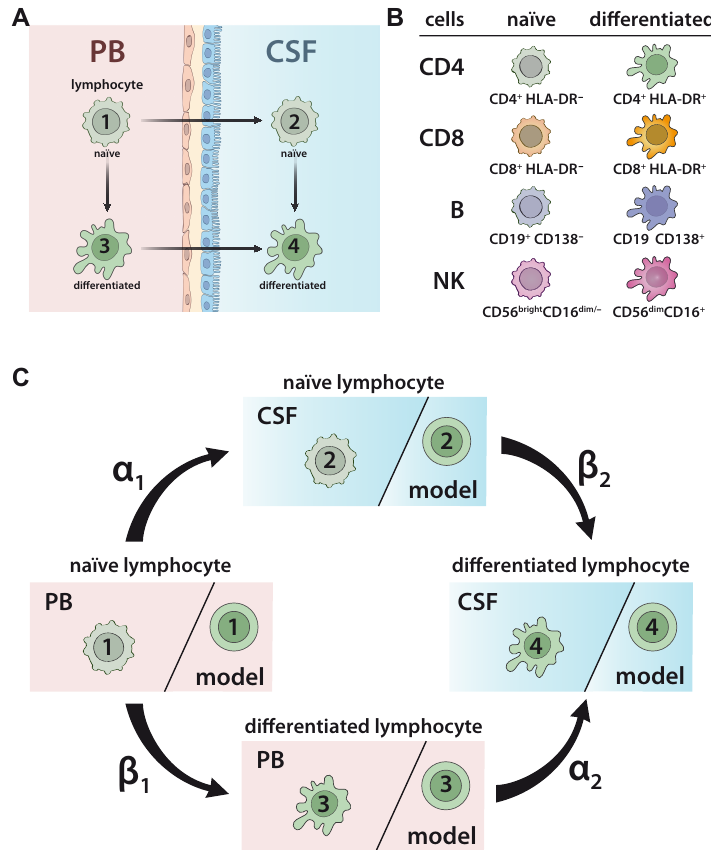
Figure 1. Model describing the relationship between naïve and di ff erentiated lymphocyte subsets in the peripheral blood (PB) and cerebrospinal fluid (CSF). ( A ) Scheme illustrating the relationship between naïve and di ff erentiated lymphocytes in the peripheral blood (PB) and cerebrospinal fluid (CSF). Naïve lymphocytes (stage 1) can either migrate from the PB compartment into the CSF compartment (transition from stage 1 to stage 2) or di ff erentiate within the PB compartment (transition from stage 1 to stage 3). Di ff erentiated lymphocytes (stage 3) can migrate from the PB compartment into